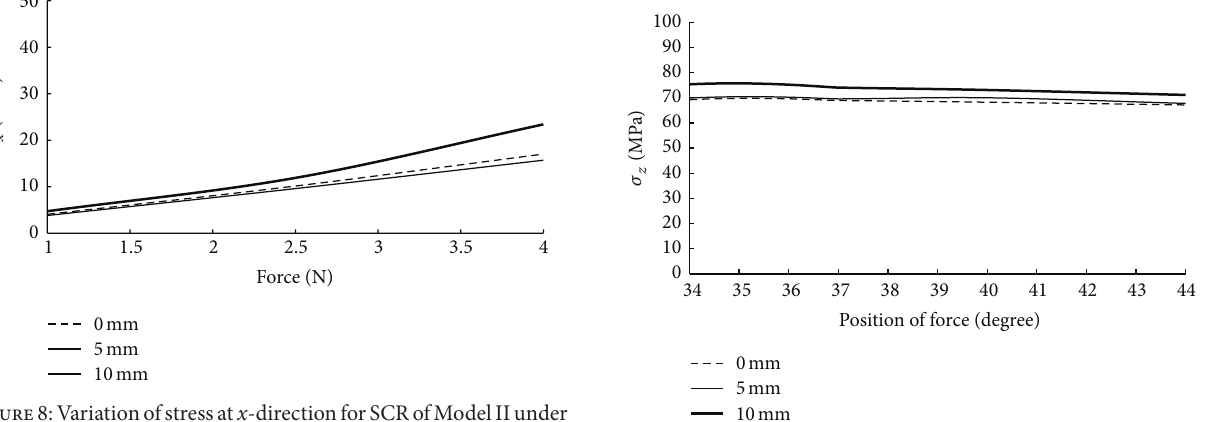
Figure8:Variationofstressat x -directionforSCRofModelIIunder the position angle of 34 ∘ .